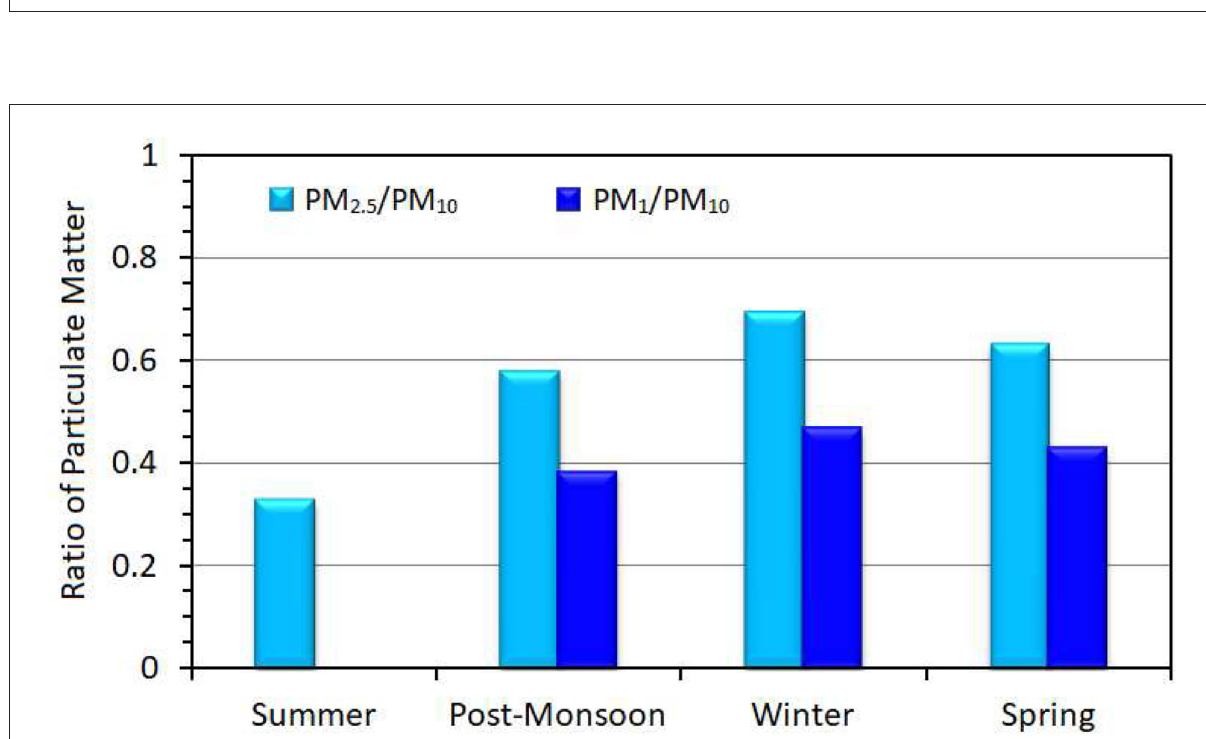
FIGURE4 Daily variation in the ratio of particulate matters (PM 1 , PM 2.5 with PM 10 ) from April 2019 to March 2020 over Varanasi.